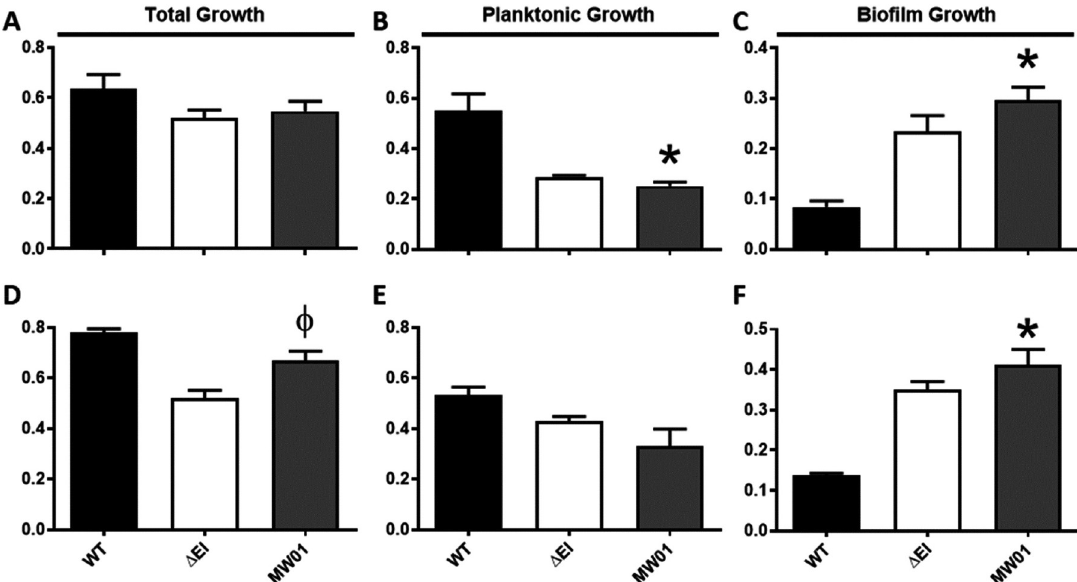
Fig 3. MW01 induces V . cholerae biofilm formation without effect on total growth in LB. V . cholerae cultures were grown in borosilicate tubes in LB broth supplemented with 0.2 mg/mL of MW01 (A–C) or 0.1 mg/mL of MW01 (D–F). After 18 hours of incubation at 27˚C, biofilm cells were harvested and quantified for total growth (A and D), planktonic growth (B and E), and biofilm growth (C and F). Data are shown for a PTS mutant ( Δ EI) positive control growth in LB, wild-type V . cholerae (WT) in LB alone, and WT in LB supplemented with the compound. � and Ø denotes statistical significance (p < 0 . 05) from WT and Δ EI control values respectively.